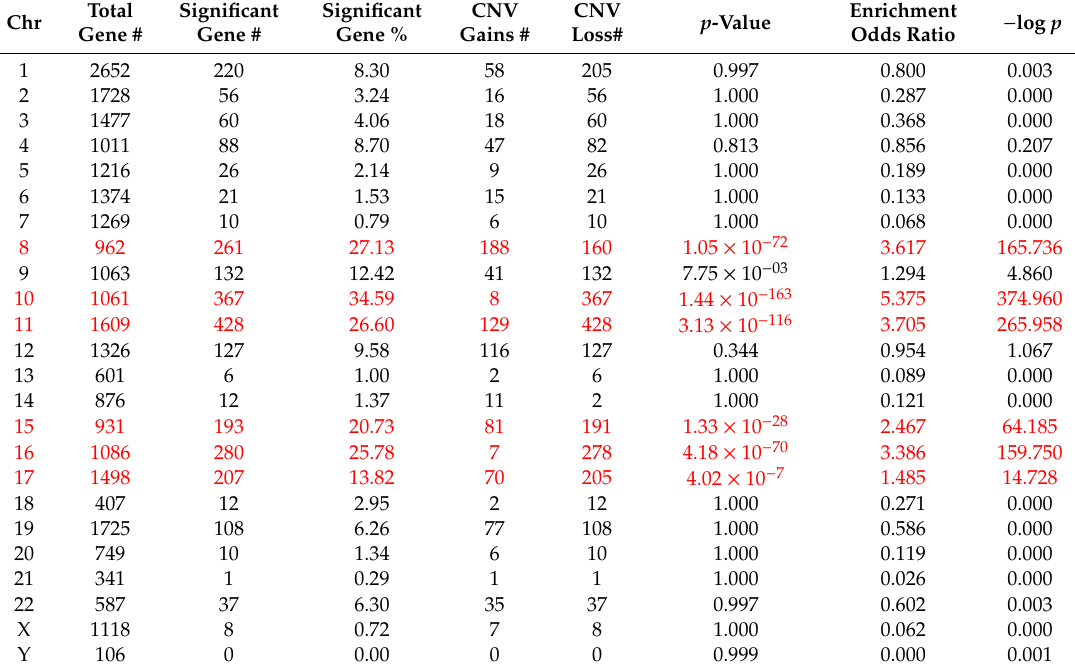
Table 1. Enrichment analysis of significant CNVs observed in genes across various chromosomes. The enrichment odds-ratio (OR) of a chromosome means the ratio of the CNV gene-enriched odds from this chromosome over the other chromosomes’ CNV gene-enriched odds. The enrichment p -value was calculated from a chi-square test from a 2 by 2 table, in which CNV gene enrichment in one chromosome was compared to all the others. The p -value was obtained from a one-sided test for OR > 1. Chr, chromosome. Chromosomes listed in red have significantly more genes with CNVS associated with patient overall